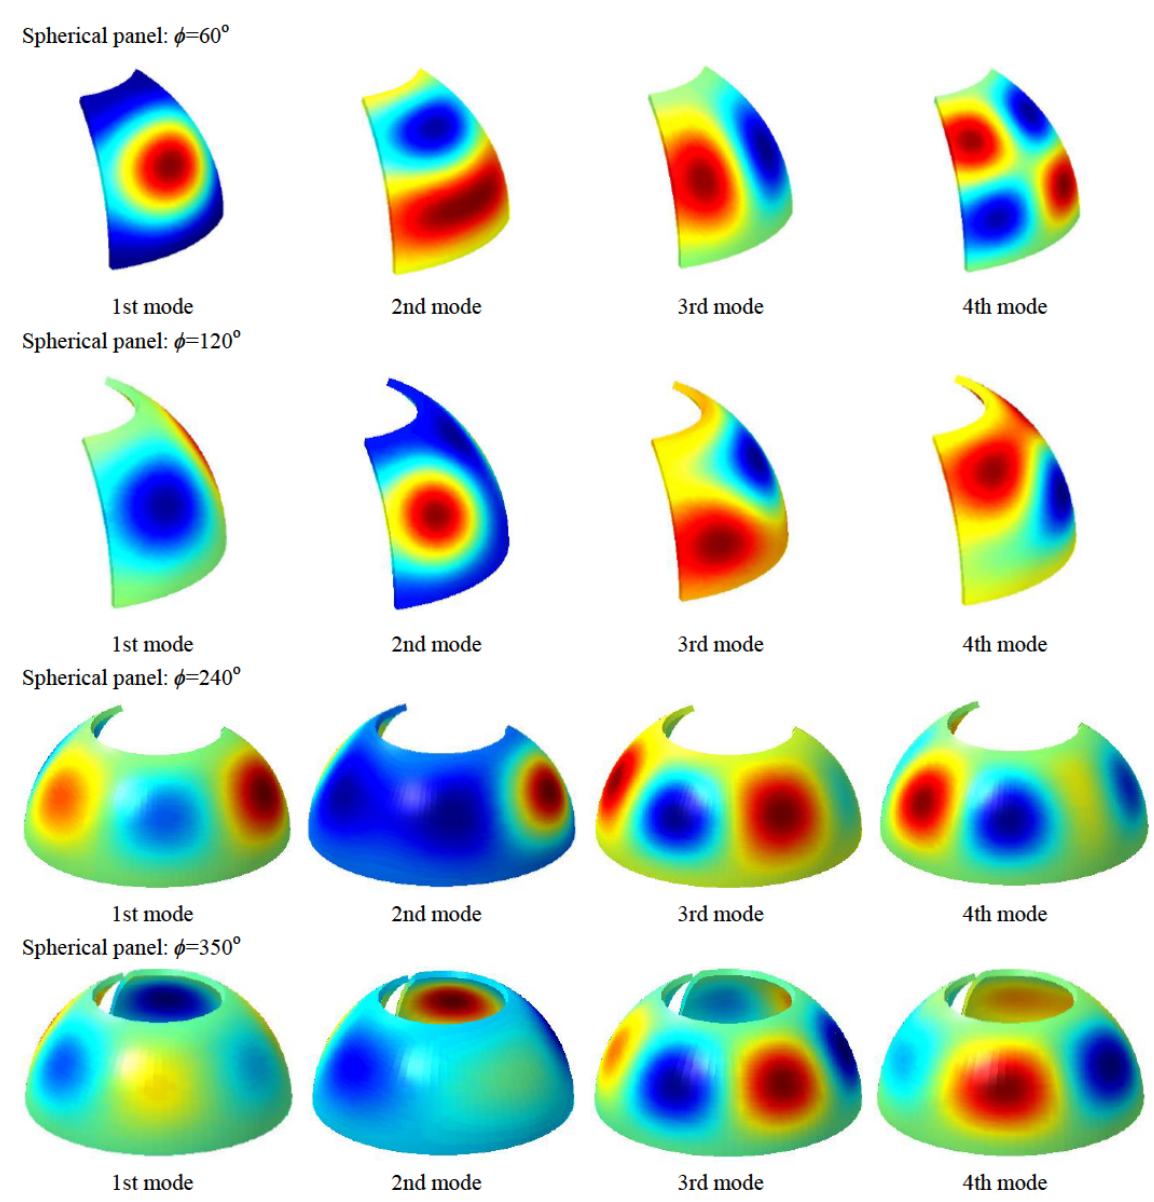
Figure 8: Mode shapes of the Spherical panel with CE 1 CE 1 boundary